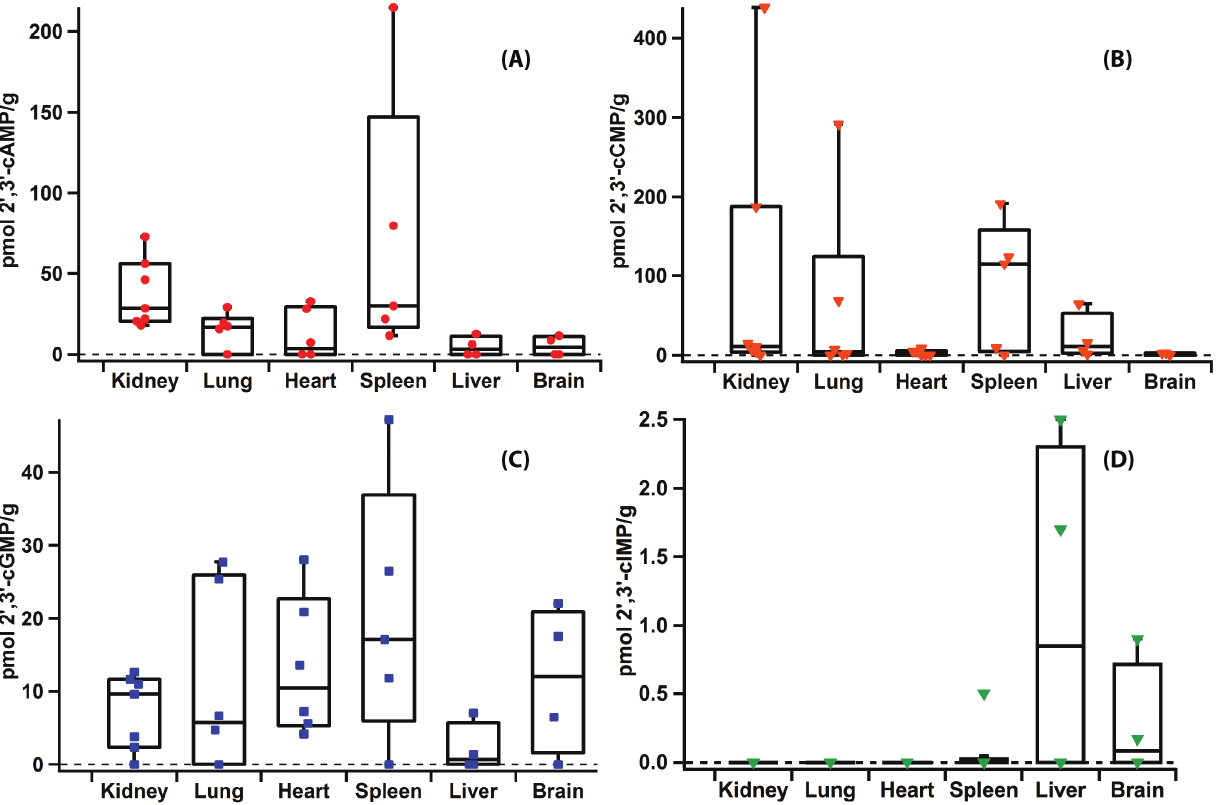
Figure 7. Levels of extracted 2',3'-cNMPs (pmol/g wet tissue) in rat organs. Each point represents the level measured in a replicate from a different rat. ( A ) 2',3'-cAMP; ( B ) 2',3'-cCMP; ( C ) 2',3'-cGMP; ( D ) 2',3'-cIMP. Whisker top: 90 percentile, box top: 75 percentile, box middle: 50 percentile, box bottom: 25 percentile and whisker bottom: 10